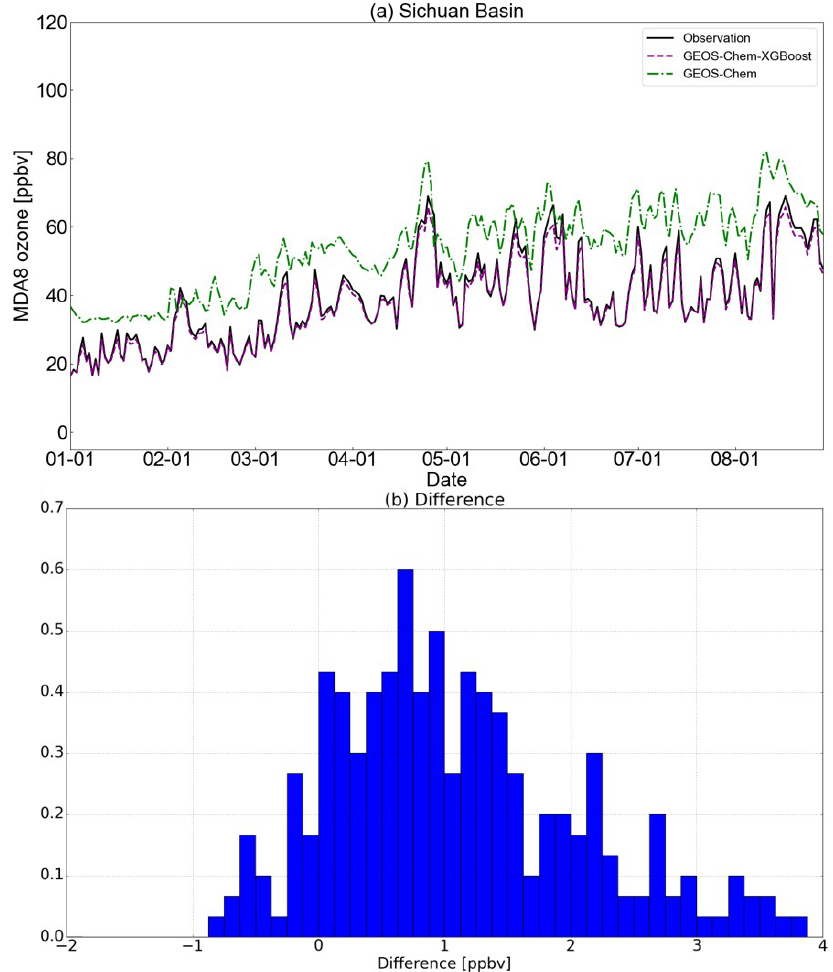
Figure 3. Measured and modelled O 3 variability over the SCB in 2019 (a) . Measured, GEOS-Chem-predicted, and GEOS-Chem-XGBoost- predicted O 3 values are denoted by black solid, grey dashed, and purple dashed lines respectively. Panel (b) presents a histogram of the differences between the GEOS-Chem-XGBoost predictions and the